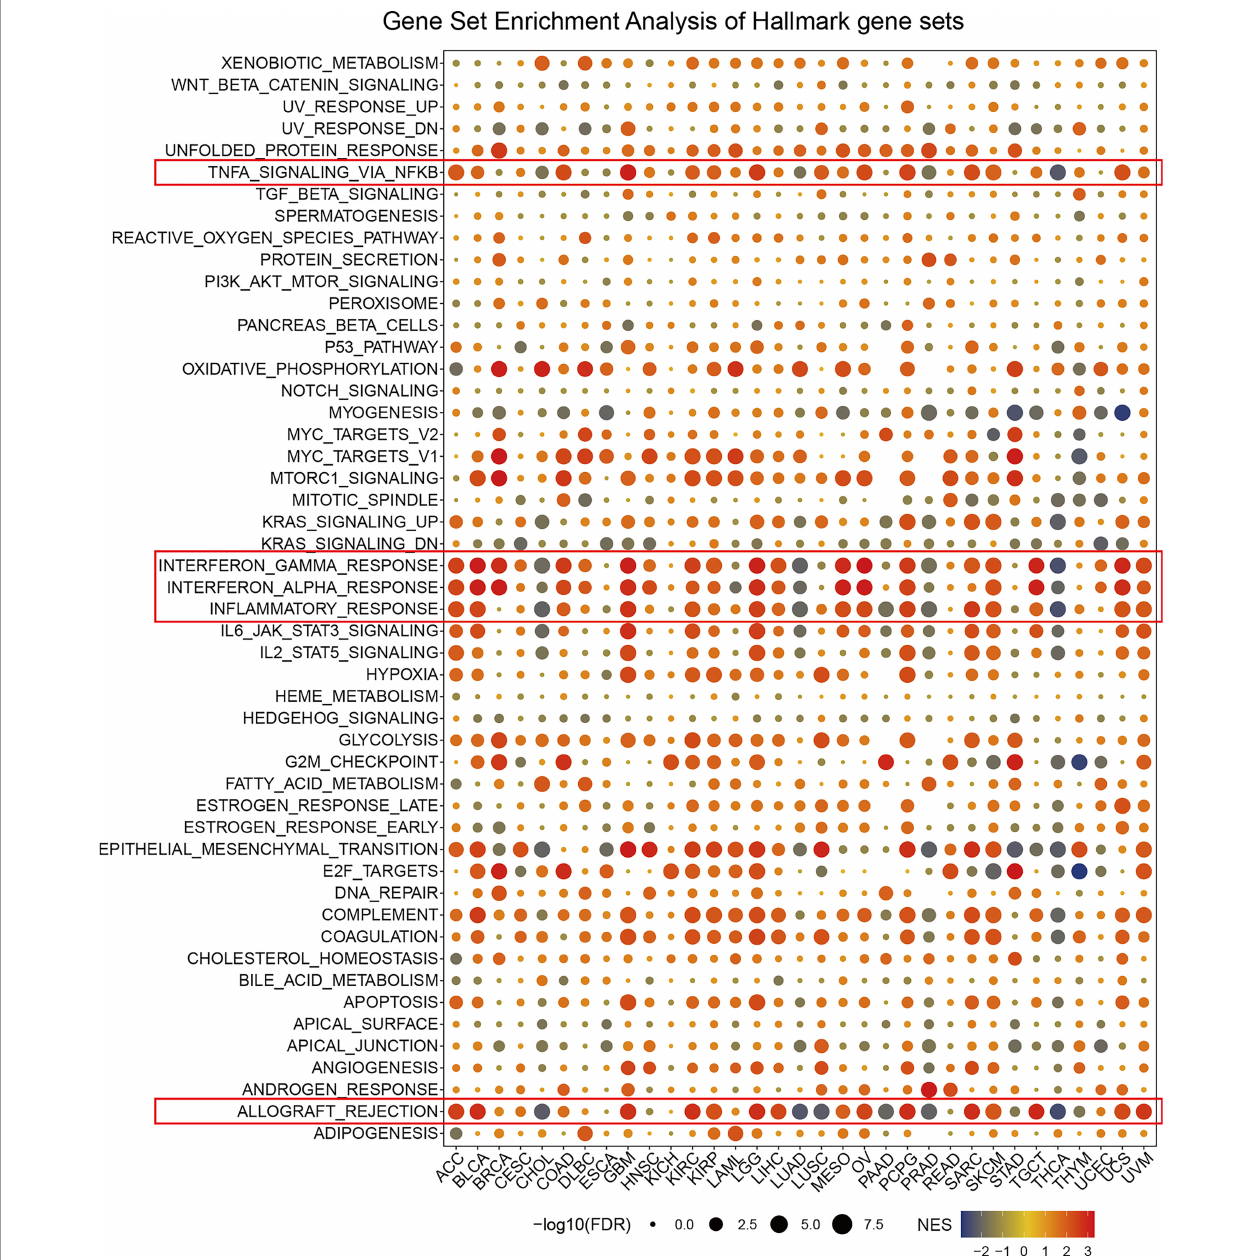
FIGURE 4 | The hallmarks gene set enrichment analysis of PDIA3 in pan-cancer. The size of circle represents the FDR value of enrich term in each cancer, and the color indicates the normalized enrichment score (NES) of each